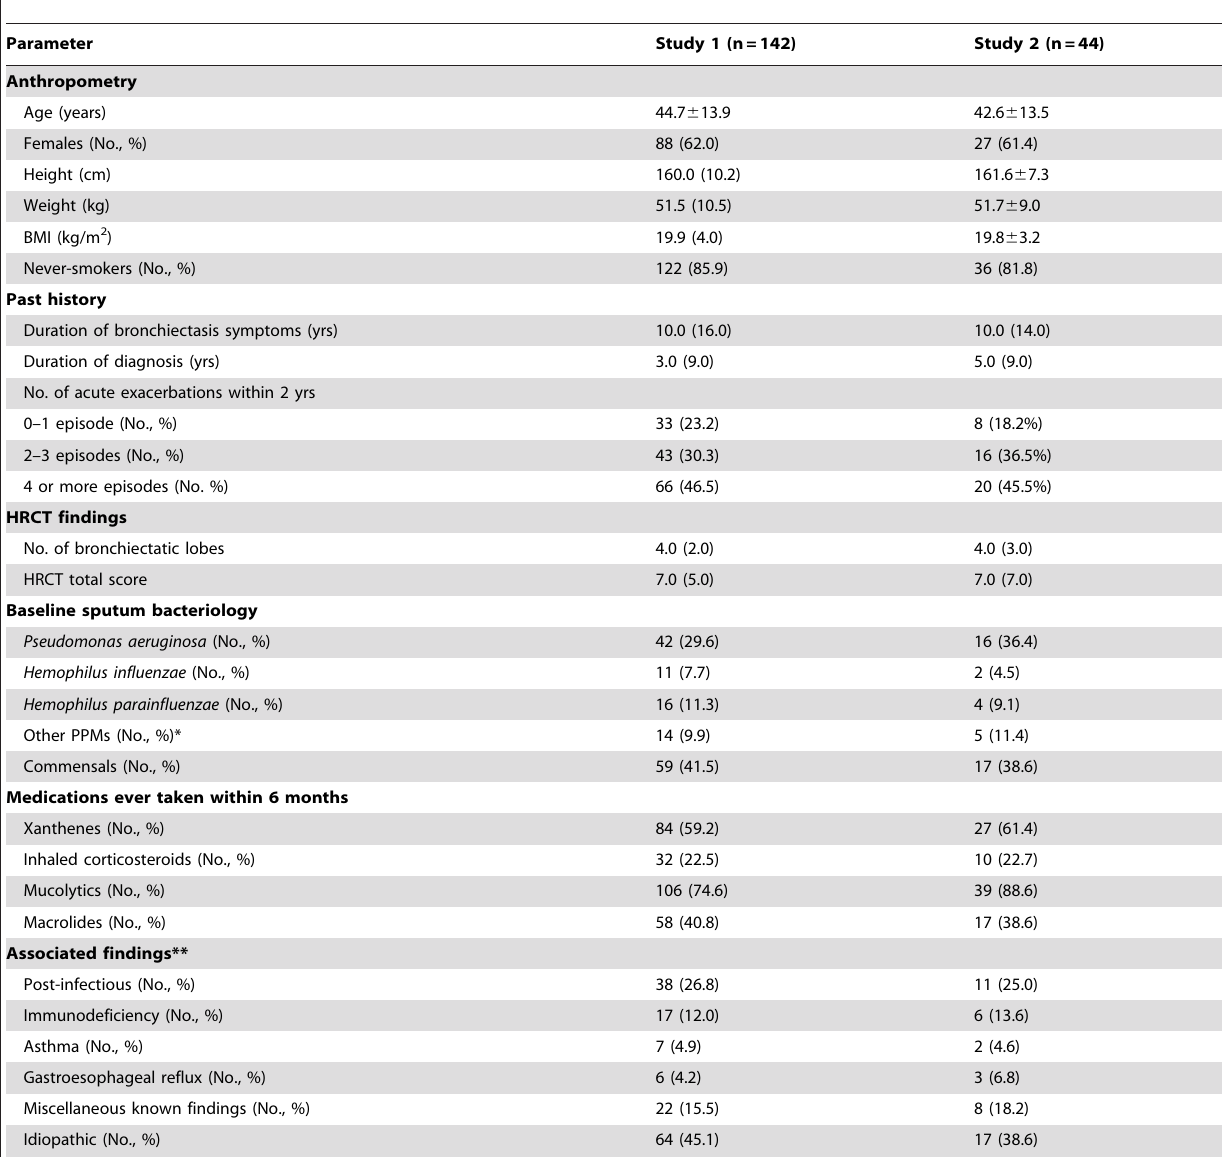
Table 1. Baseline characteristics of bronchiectasis